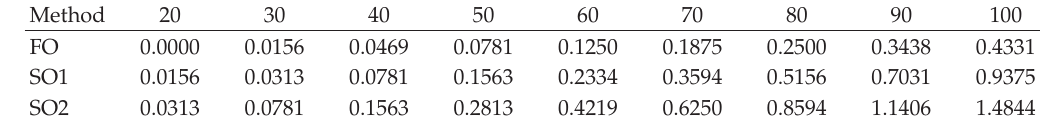
Table 2: CPU times.